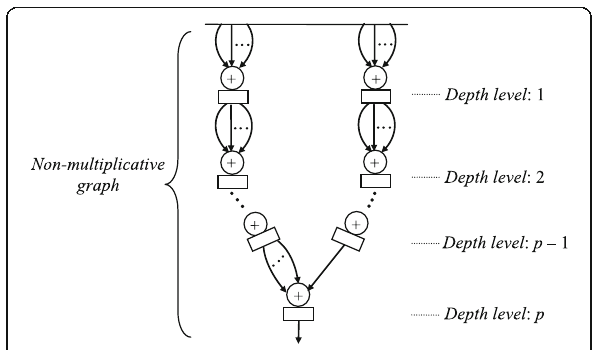
Fig. 9 Non-multiplicative graph that generates the maximum number of non-zero digits, n p , with the minimum number of R -operations in non-multiplicative graphs